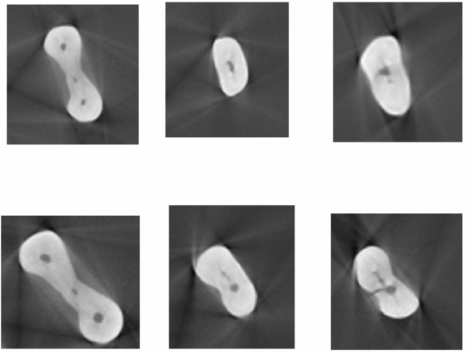
Figure 3. Sections of moderately curved mesial roots before ( up ) and after ( down ) instrumentation.